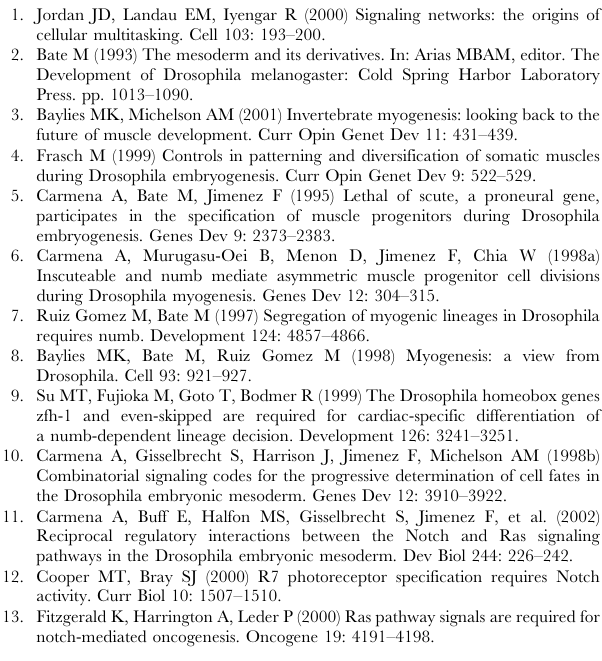
Figure S3 Cno represses Ras-MAPK signaling pathway. Three hemisegments (lateral views) of stage 11 embryos are shown at high magnification (63 6 ). (A–D) In wildtype embryos, diP-MAPK expression (green) is restricted along with Eve (blue) to the progenitor. (E–L) An expansion of diP-MAPK expression is detected both in cno2, aos D 7 (E–H) and in cno2, DlX (I–L) transheterozygotes (arrows). The transcription factor Twist (Twi, red) marks mesoderm. tp, tracheal pits.